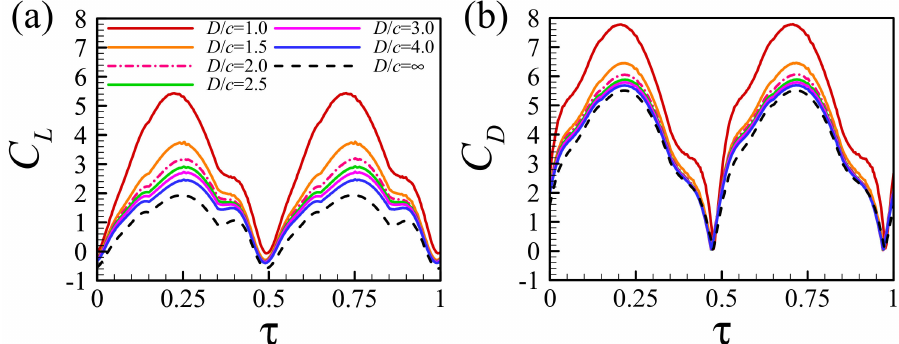
Figure 4. The transient aerodynamic ( a ) lift and ( b ) drag coefficient ( C L and C D ) distributions for one flapping cycle at systematic wall clearances ( D / c ) and Re = 10.